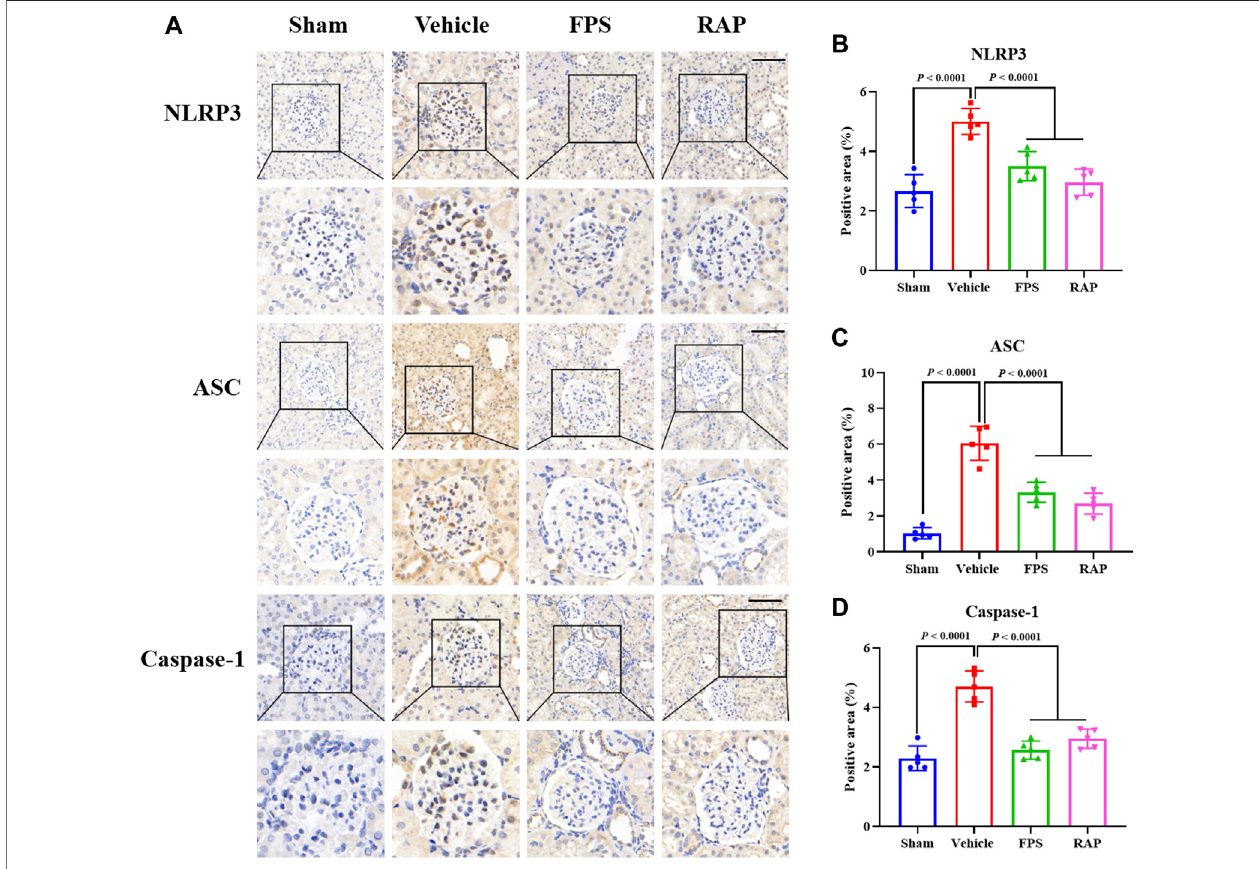
FIGURE 9 | Effects of FPS and RAP on the expression characteristic of NLRP3 in fl ammasome in vivo . (A) The immunostaining of NLRP3, ASC, and Caspase-1 in glomeruli (×400). Scale bar = 50 μ m. (B – D) The positive area of NLRP3, ASC, and Caspase-1, respectively. The data are expressed as the mean ± SD.